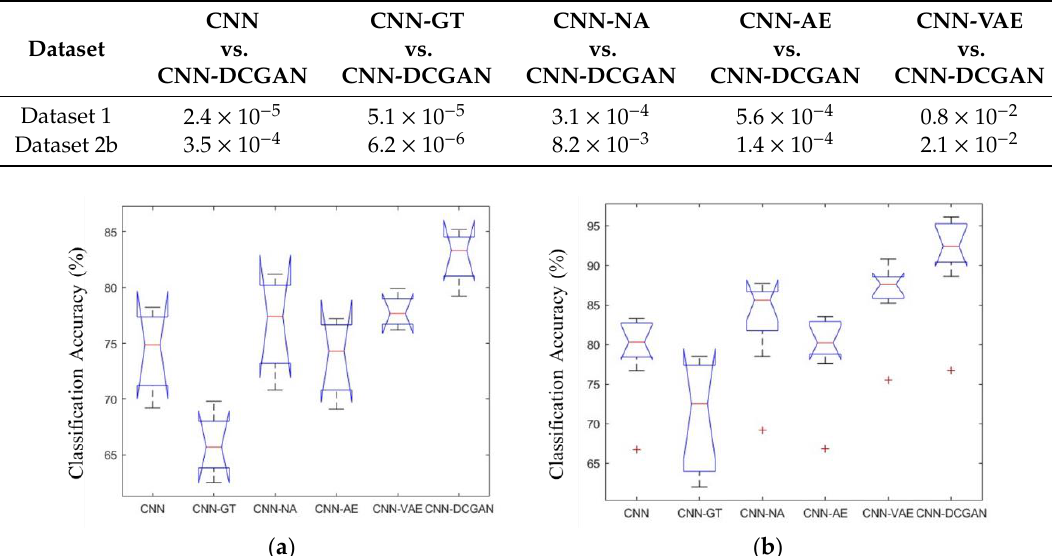
Table 10. Paired t -test results ( p -values) between the CNN-DCGAN and other methods.